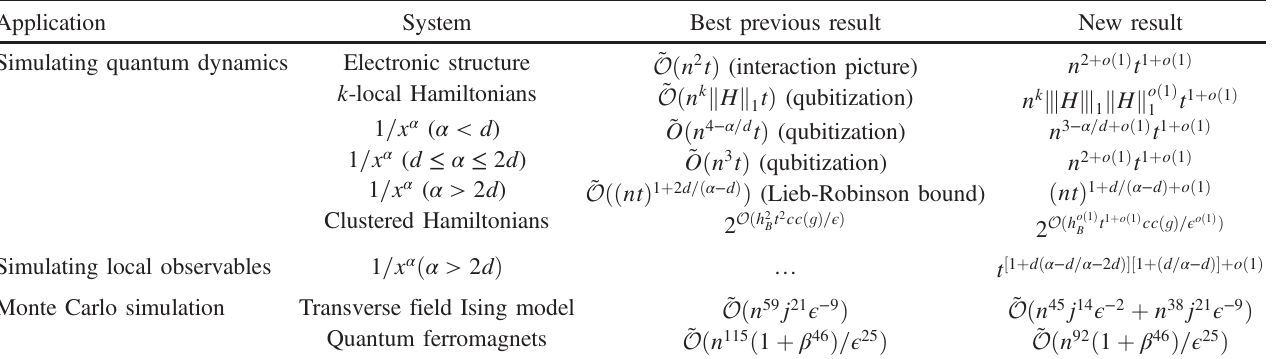
TABLE I. Comparison of our results and the best previous results for simulating quantum dynamics, simulating local observables, and quantum Monte Carlo simulation.